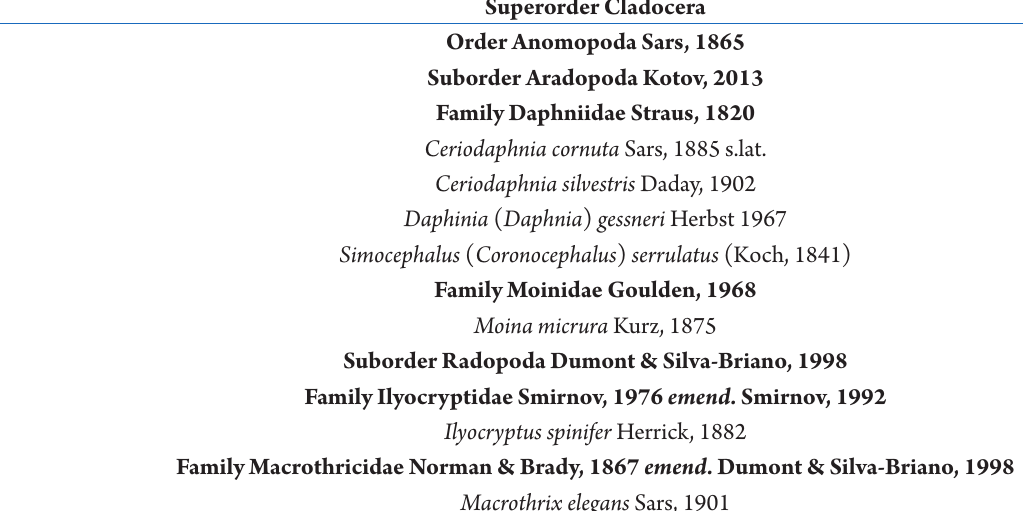
Table 1. Cladoceran species from Lake Paranoá based on Elmoor-Loureiro et al ., (2004), Sousa and Elmoor-Loureiro (2012), Elmoor-Loureiro (2013), Sousa et al., (2015a, b), Sousa et al., (2016). * First records. Higher classification follows Kotov